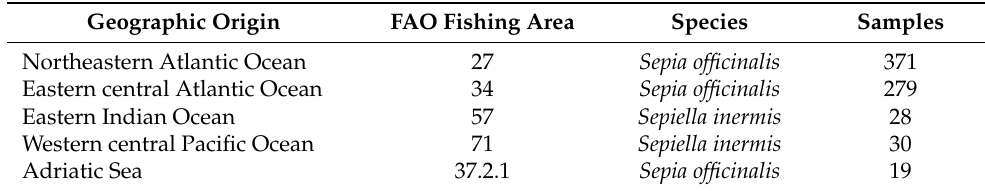
Table 1. Geographic origin, correspondent FAO fishing area, and description of cuttlefish species included in the